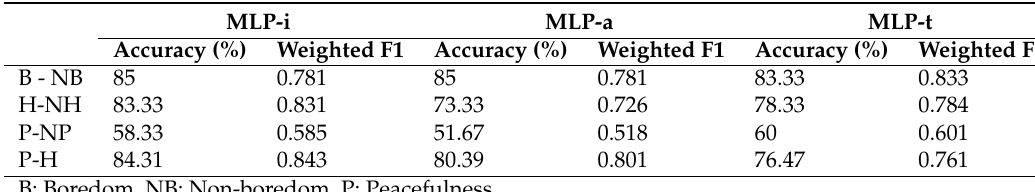
Table 14. LOOCV results for MLP models in binary